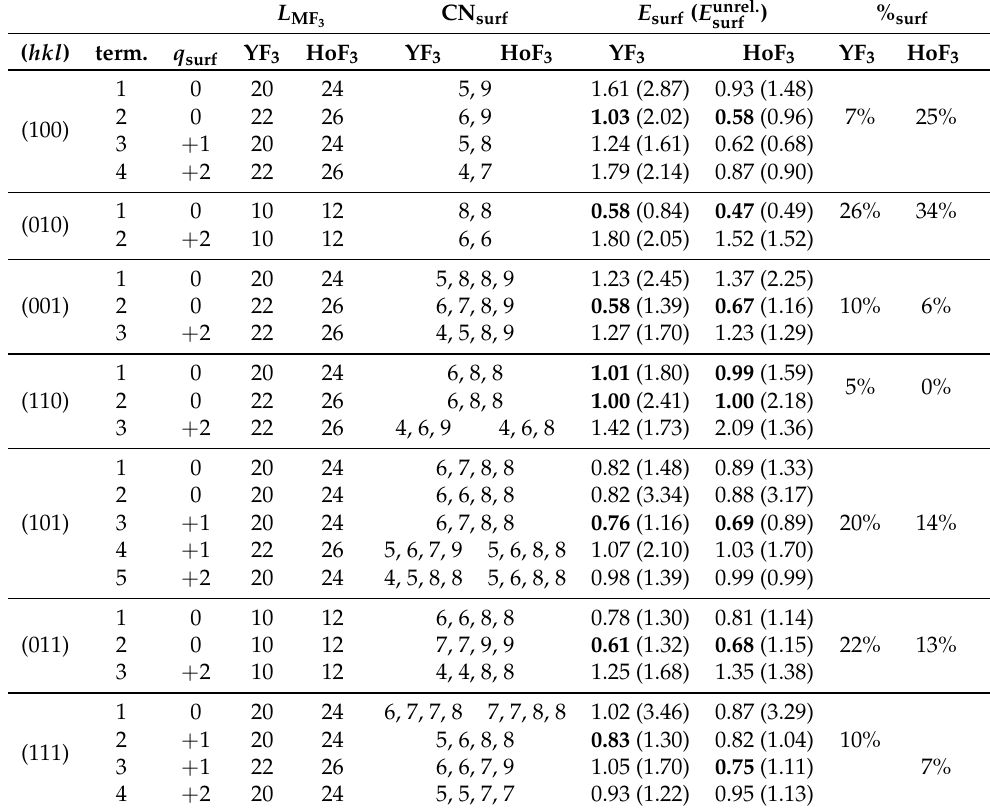
Table 2. The YF 3 (PBE) and HoF 3 (PBE+U d /3 eV/4f-in-core) surfaces with respective terminations (term.), slab thickness in layers of formula units without terminal F-deficit ( L MF ), nominal surface 3 net charge ( q surf ) in e, surface energies of relaxed ( E surf ) and unrelaxed slabs ( E unrel. ) in Jm − 2 , as well surf as the relaxed surface metal coordination number (CN surf ). The lowest surface energies per ( hkl ) cut are highlighted in bold. For these, also the abundance obtained by the Wulff plot (% surf ) is given. L MF CN surf E surf ( E unrel. ) % surf surf 3 ( hkl )